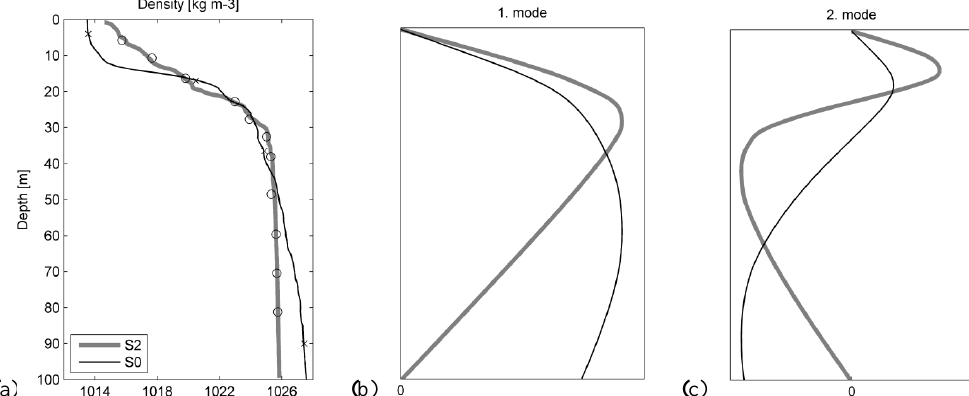
Fig. 4. (a) Comparison between density profiles measured with a CTD (lines) and moored instruments (symbols) at station S0 on 16 August 2009 and at station S2 on 18 August 2009. (b–c) The first and second mode of the vertical displacement at the two Figure 4. a) Comparison between density profiles measured with a CTD (lines) and moored 2 Figure 4. a) Comparison between density profiles measured with a CTD (lines) and moored 2 Figure 4. a) Comparison between density profiles measured with a CTD (lines) and moored 2 instruments (symbols) at station S0 August 16 2009 and at station S2 August 18 2009. b-c) 3 instruments (symbols) at station S0 August 16 2009 and at station S2 August 18 2009. b-c) 3 instruments (symbols) at station S0 August 16 2009 and at station S2 August 18 2009. b-c) 3 The first and second mode of the vertical displacement at the two stations. 4 The first and second mode of the vertical displacement at the two stations. 4 The first and second mode of the vertical displacement at the two stations. 4